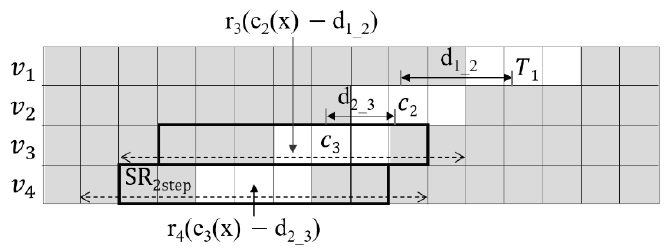
Figure 3. Fast search based on predicted